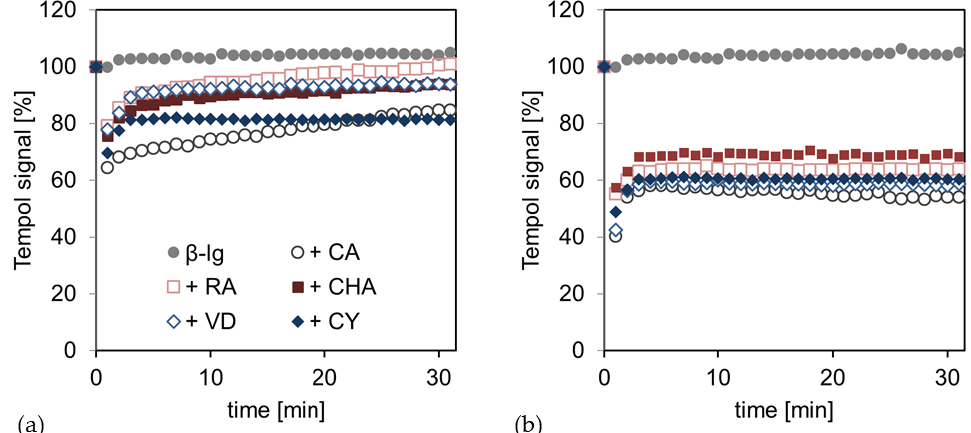
Figure 2. Tempol degradation kinetic from the aqueous phase ( a ) of the emulsion at pH 6 and ( b ) at pH 9; here, the β -Lg emulsions are compared without ( β -lg) and with PCD (+ PCD) addition. The starting point at t = 0 min represents the output signal of the pure radical. From t = 1 min onwards, the radical degradation or the radical regeneration is shown by an increase or decrease in the original radical signal. The values shown are an individual exemplary series of measurements.